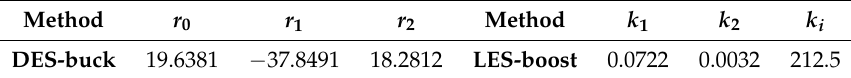
Table 4. Controllers gain designed for CPL.